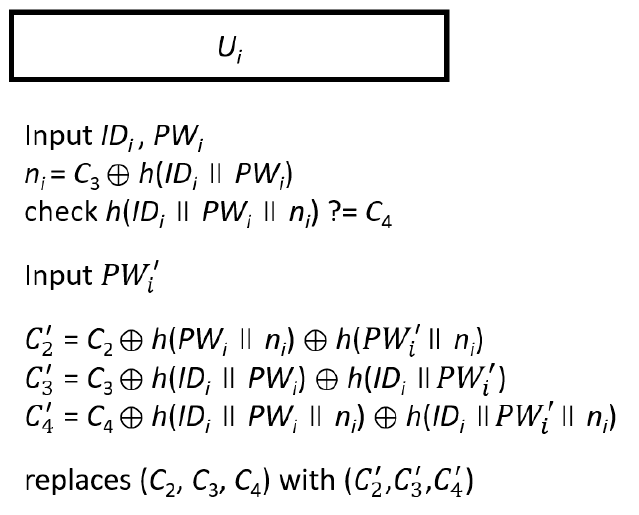
Figure 4. The flowchart of the password change phase.